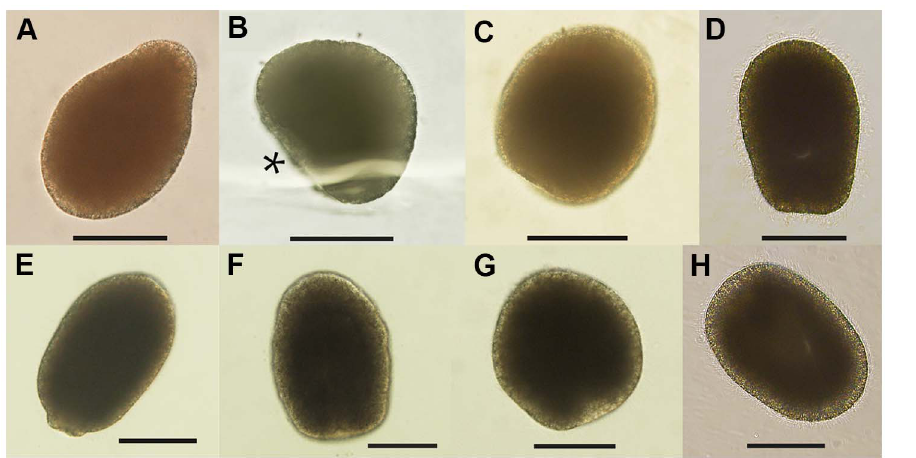
Figure 3. Light microscopy images of Lopheliapertusa embryos and larvae sampled at day 6 to 57 after spawning. Around day 6–7, embryos became piriform ( A ), followed by the formation of an indentation (*) indicating gastrulation sometime during day 6–8 ( B ). From day 10 larvae showed high plasticity, constantly shape-shifting ( C – H ). Scale bar=100 m m. Larval age: A =6; B =7; C =14; D =22; E =28; F – G =44; H =57 days